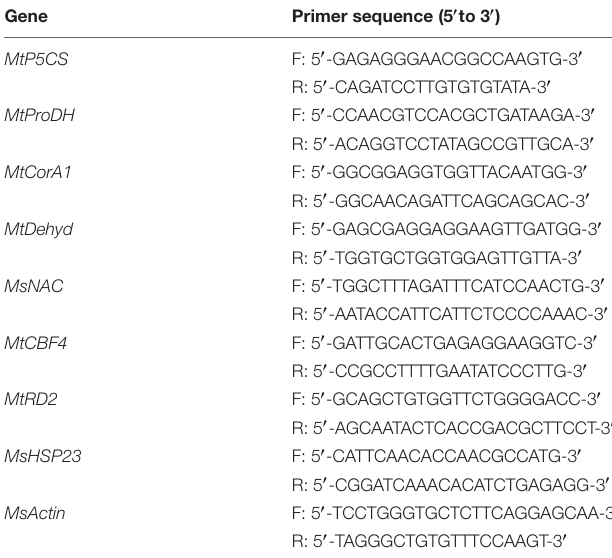
TABLE 1 | Gene-specific primers for